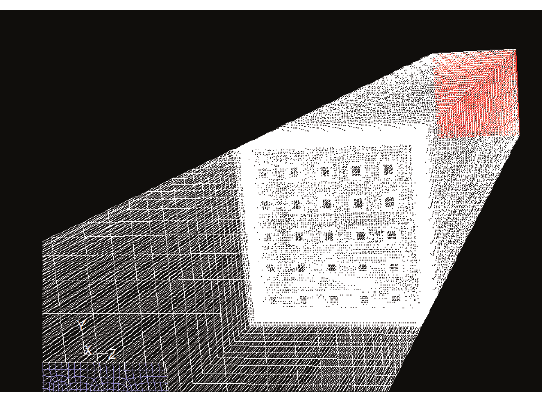
Figure 3. Computational grid: 5 × 5 in-corridor jets with square shape.